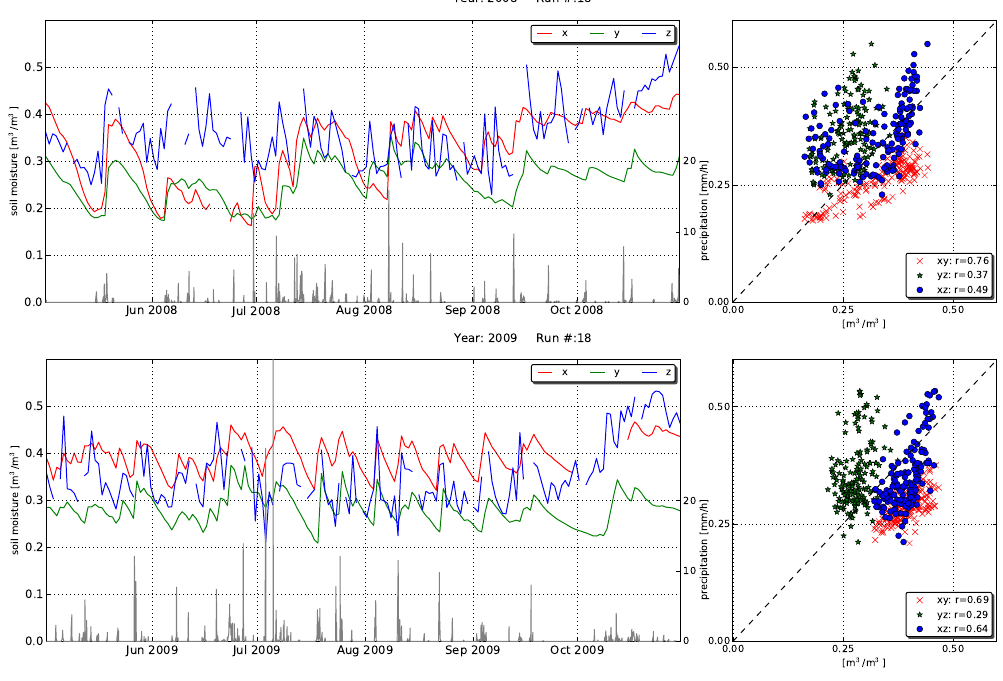
Fig. 4. Soil moisture time series for the station Steinbeissen #18 (red) and the corresponding model and satellite soil moisture time series. Precipitation information (grey bars). Scatterplot illustrates correlation between the different data tuples